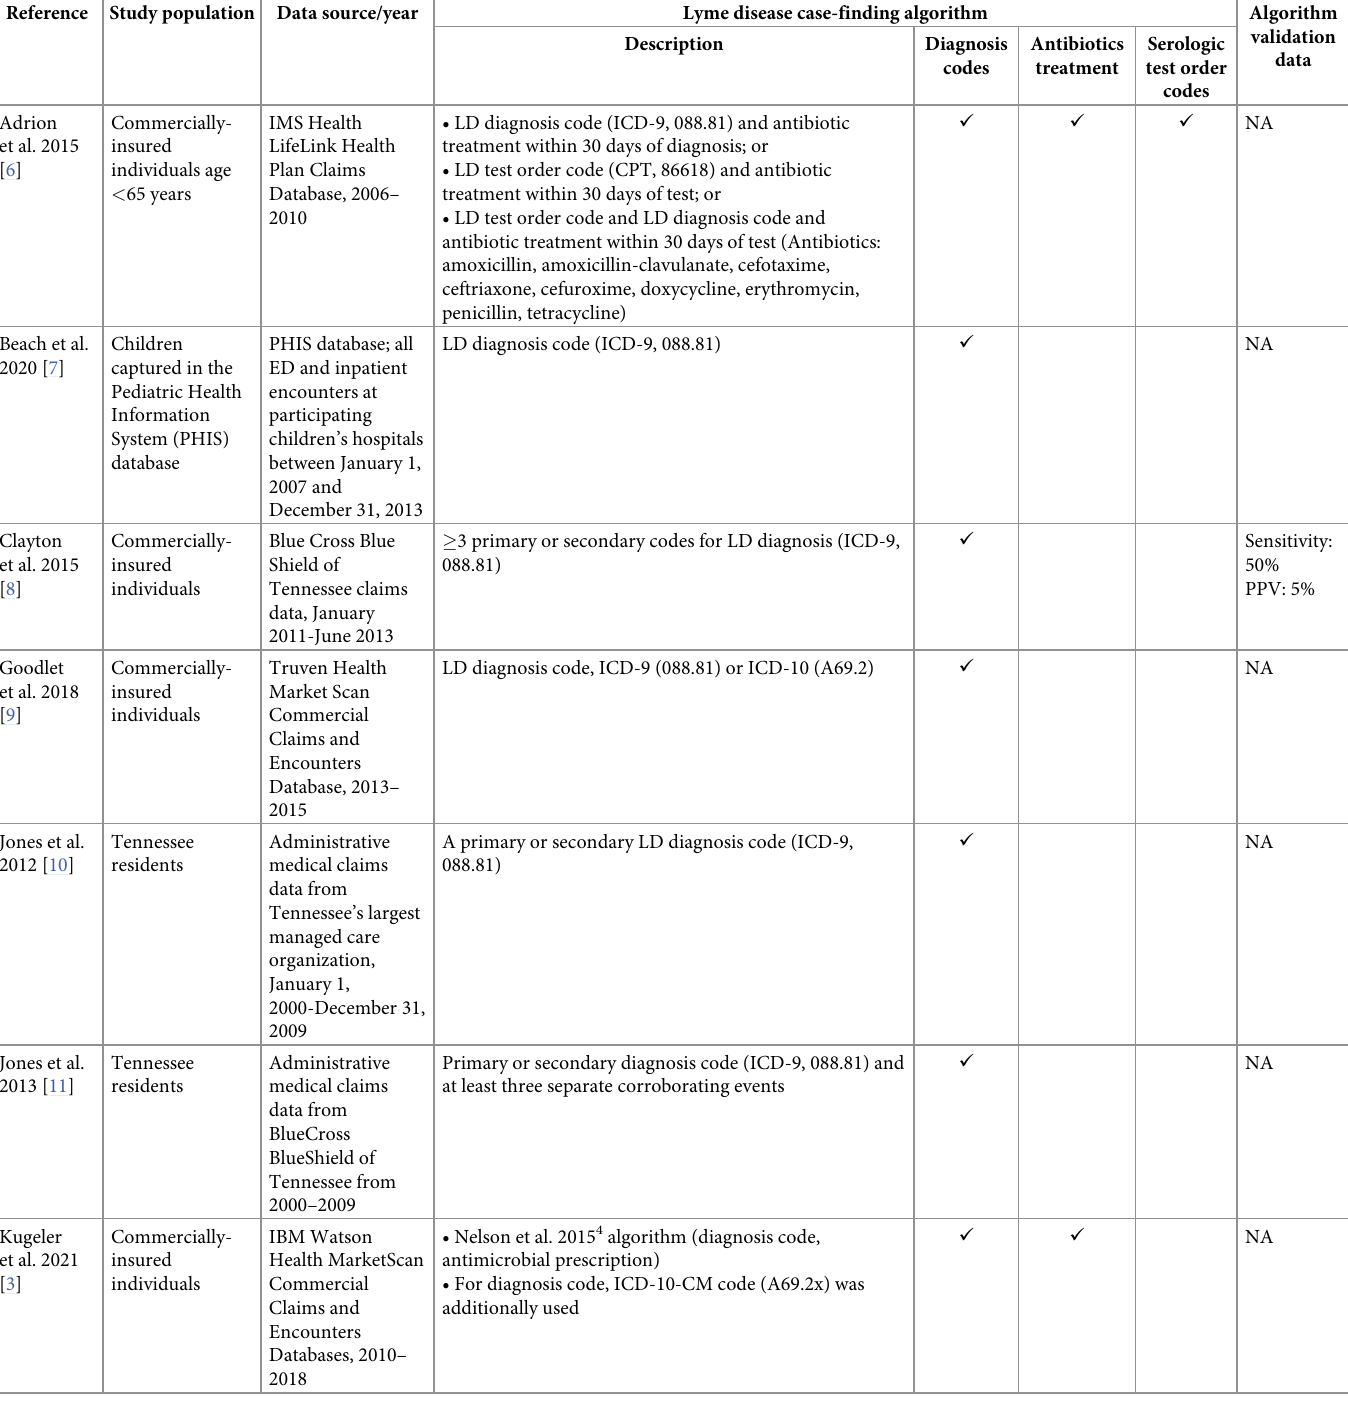
Table 1. Lyme disease case-finding algorithms used with the US administrative healthcare claims data identified in the articles published in English since 2000. Reference Study population Data